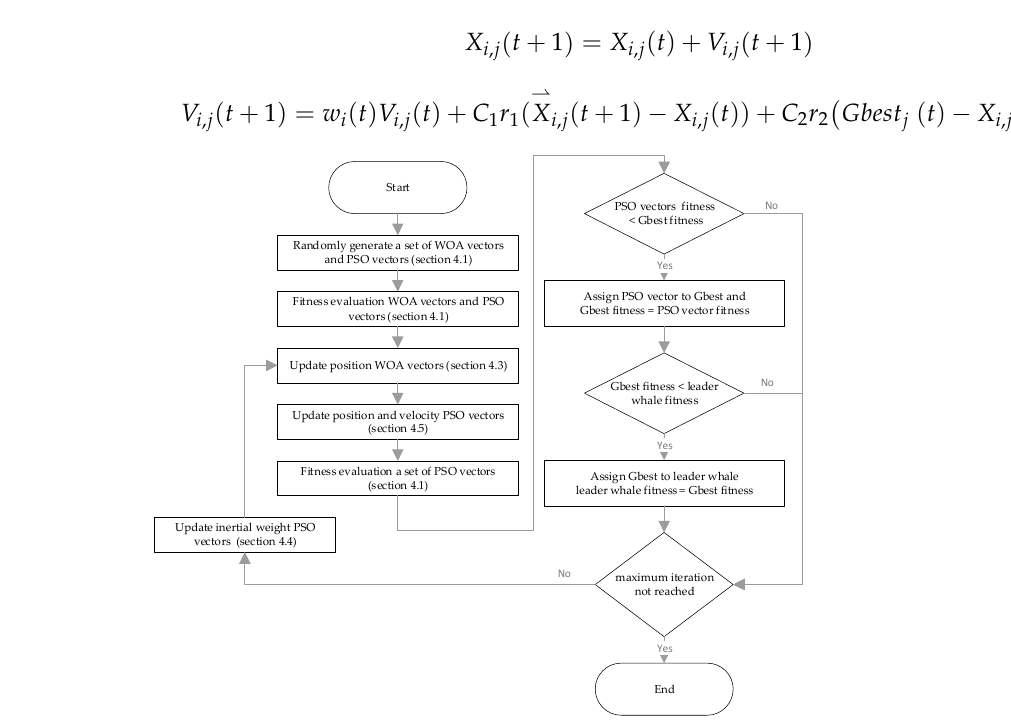
Figure 3. Flowchart of the hybrid particle swarm and whale optimization algorithm (HPSWOA).